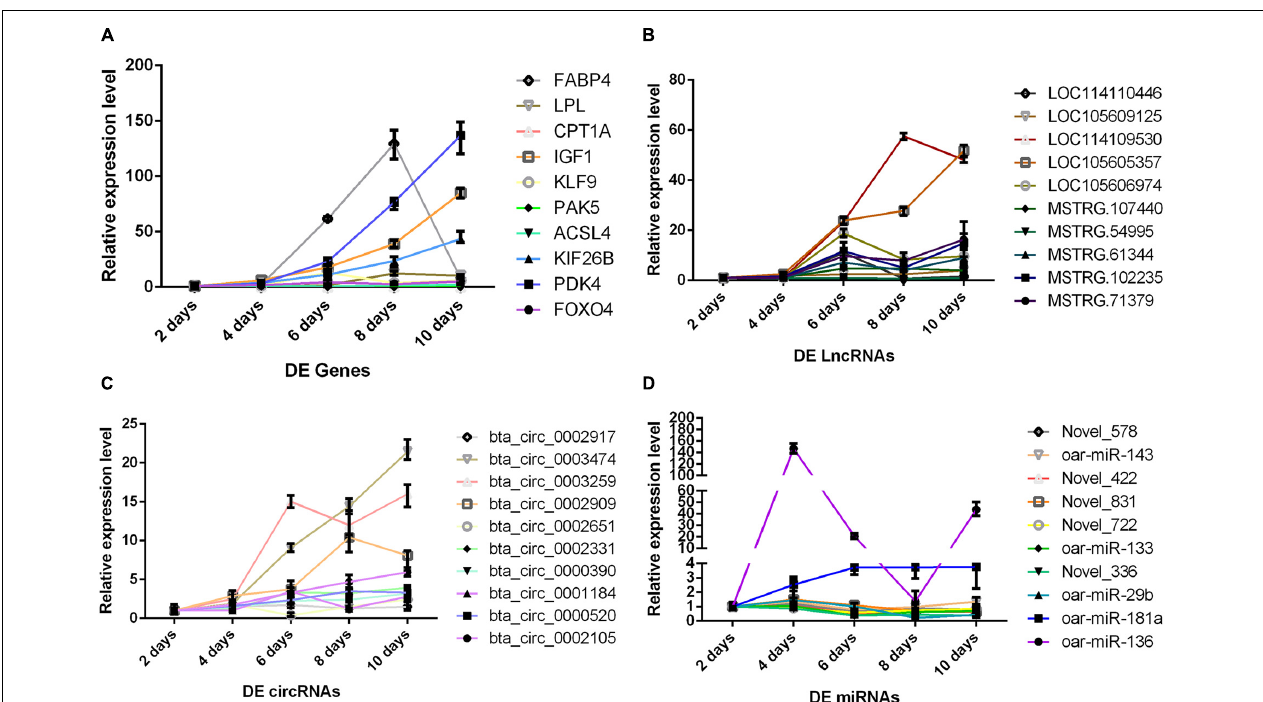
FIGURE 5 | The change trend of differentially expressed RNA during adipocyte differentiation. The abscissa is the different days of cell culture, the ordinate is relative expression level, different colored lines represent different RNAs. (A) Messenger RNA (mRNA) results by qPCR. (B) Long non-coding RNA (lncRNA) results by qPCR. (C) Circular RNA (circRNA) results by qPCR. (D) MicroRNA (miRNA) results by